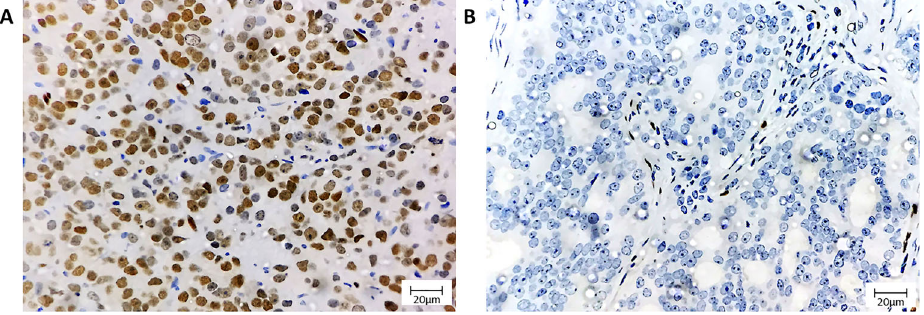
Figure 2. ETS-related gene (ERG) immunohistochemistry. A , Nuclear ERG positivity in prostate cancer. B , Negative expression in prostate cancer with positive nuclear internal control in endothelial cells. Magni fi cation bar: 20 m